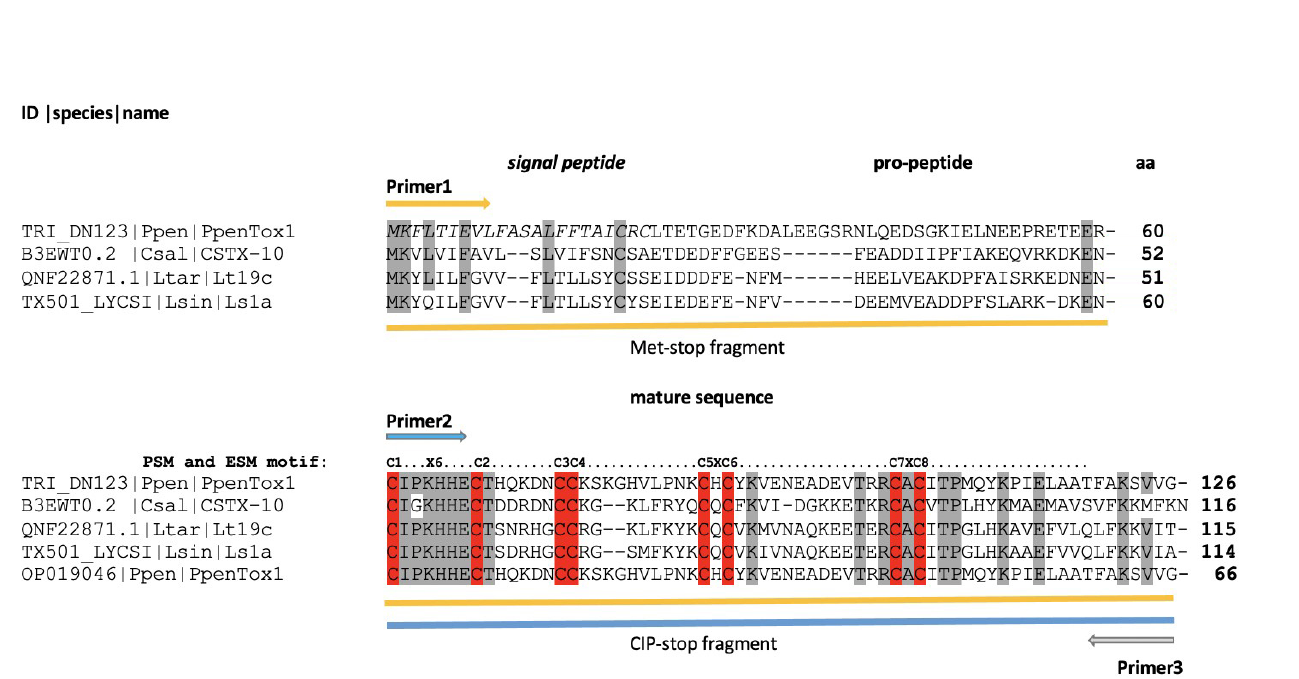
Figure 6. Multiple sequence alignment of amino acid sequences translated from the transcript sequence TRINITY_DN123_c0_gl_i2 (toxin-like PpenTox1). Ppen: Phonotimpus pennimani ; Csal: Cupiennius salei ; Ltar: Lycosa tarantula ; CSTX-10: C. salei toxin CSTX-10 (GenBank B3EWT0.2); Lt19c: L. tarantula toxin U2- lycotoxin-Lt19c (GenBank QNF22871.1); Ls1a: L. singoriensis toxin U5-lycotoxin-Ls1a (UniProtKB B6DCV0). The underscored part corresponds to the Met-stop fragment (381 bp; primers 1 and 3) and the Cys-rich truncated CIP-stop fragment (201 bp; primers 2 and 3; GenBank OP019046), which was used in PCR amplification from DNA and qPCR experiments. The Cys residues that participate in folding are indicated in red. The PSM and ESM Cys distribution patterns are shown in the horizontal bar above the CIP-stop sequences. Arrows correspond to the primers from Table